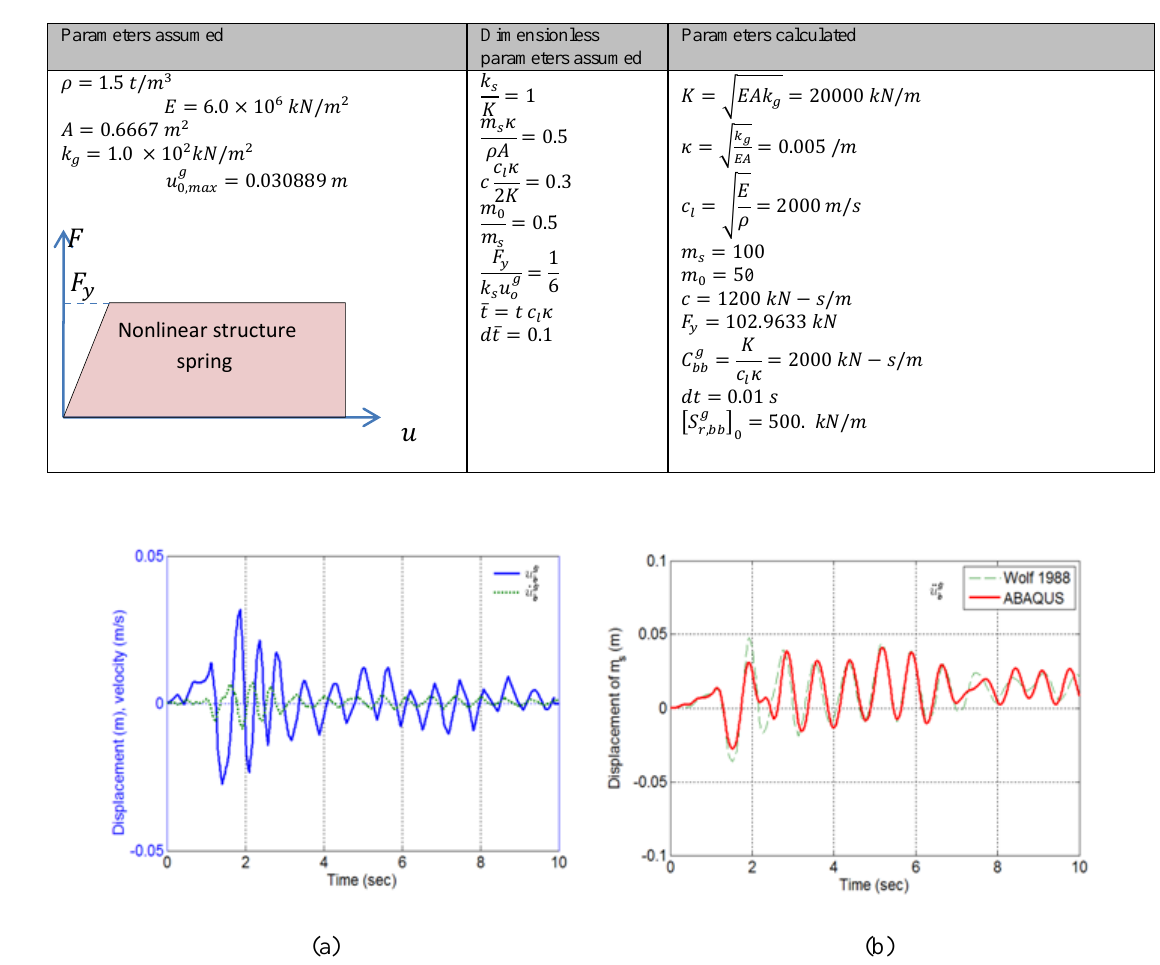
Table 2. Parameters for 2DOF system (Wolf, 1988)